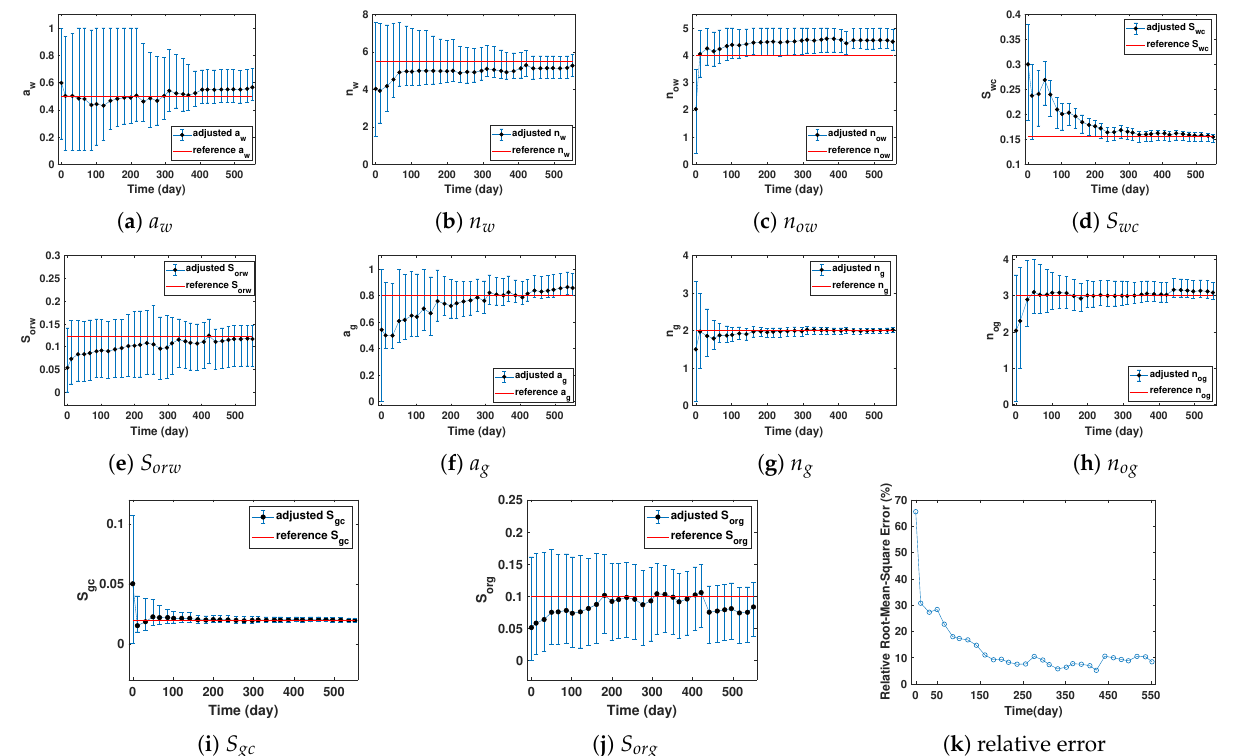
Figure 9. The reference values, the adjusted parameters and the relative root mean square errors the at different time with unknown endpoints. The red line denotes the true reference (true) value of a parameter. The black dot denotes the mean of an ensemble. The blue bar denotes the maximum and minimum deviations from the mean.